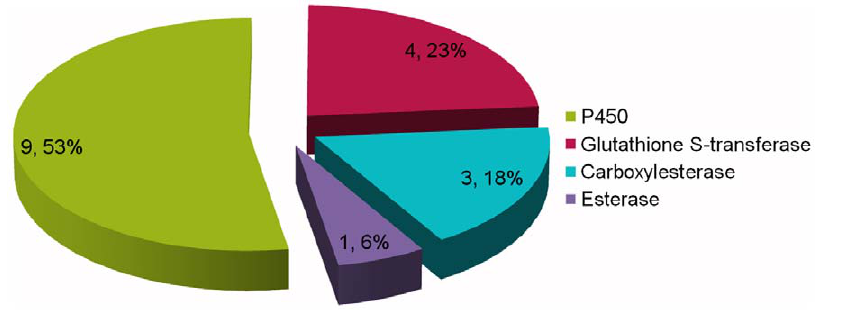
Figure 6. Pie chart representation of several genes, mainly implicated in insecticide metabolism. The number preceding the each percentage indicates the number of unigenes encoding a specific metabolism enzyme with log 2 Ratio greater than 2. The percentages indicate the propotion of each specific unigenes in four kinds of known enzyme unigenes. doi:10.1371/journal.pone.0028516.g006 PLoS ONE |